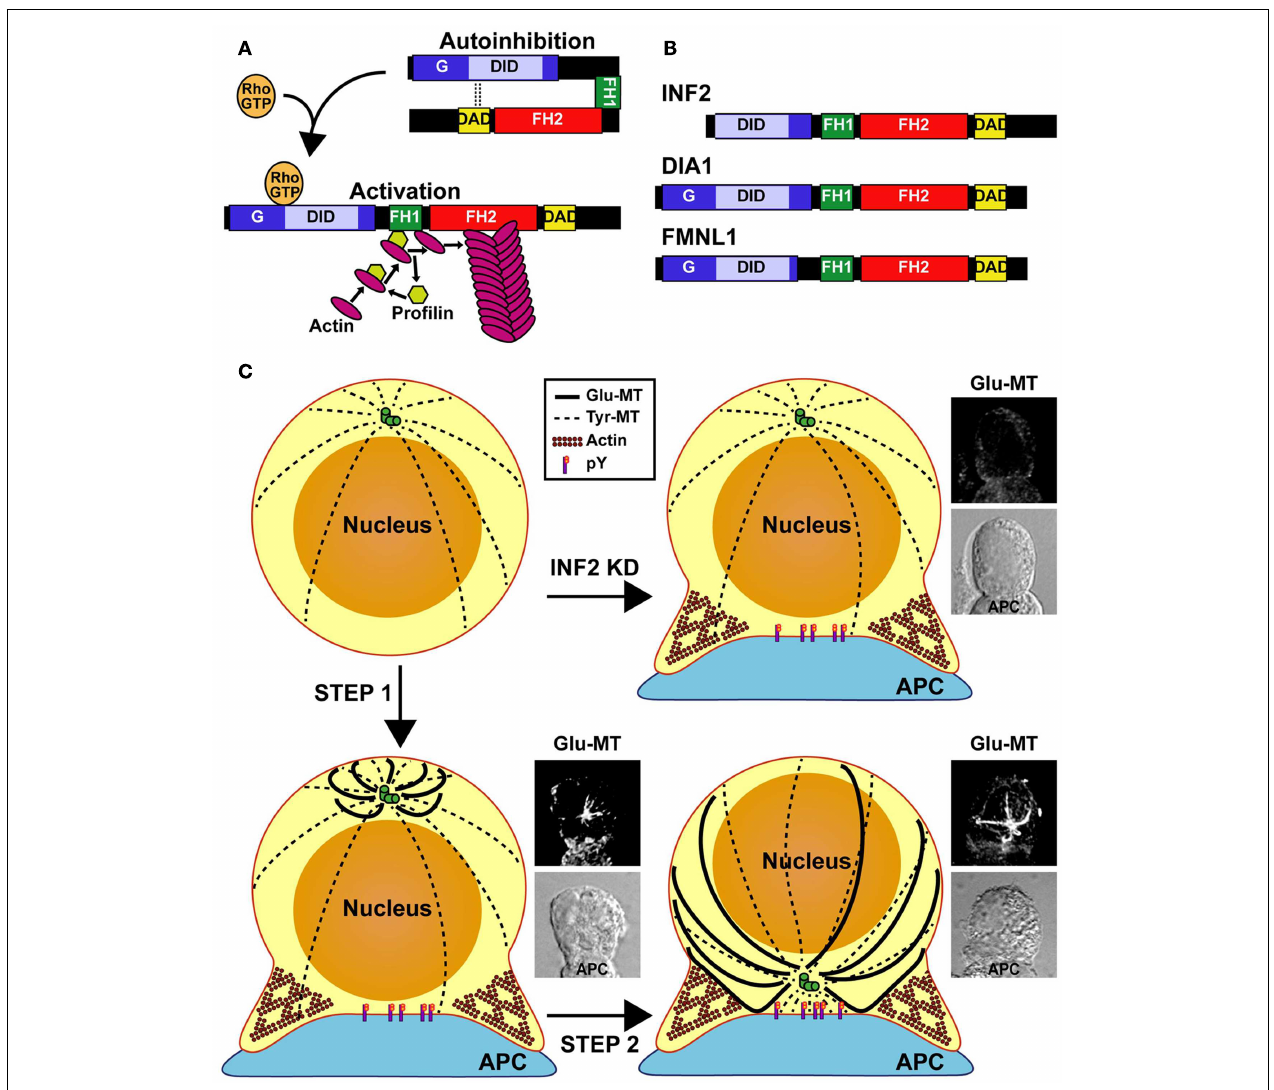
antigen-presenting cell (APC), INF2 and other formins promote the formation of a Glu-MT array in theT cell, which pushes the MTOC (Step 1). Simultaneously, Src kinase dependentTCR signaling (phosphotyrosine, pY) directs the movement of the MTOC toward the IS. Finally, Glu-MTs would maintain the MTOC at the IS and could be used for membrane trafficking from the ( + ) MT ends, situated at the posterior part of the cell, toward MTOC-located ( − ) MT ends (Step 2). In the absence of INF2 (INF2 KD), no Glu-MTs are formed and the MTOC cannot move even though Fyn and Lck-dependent tyrosine phosphorylation takes